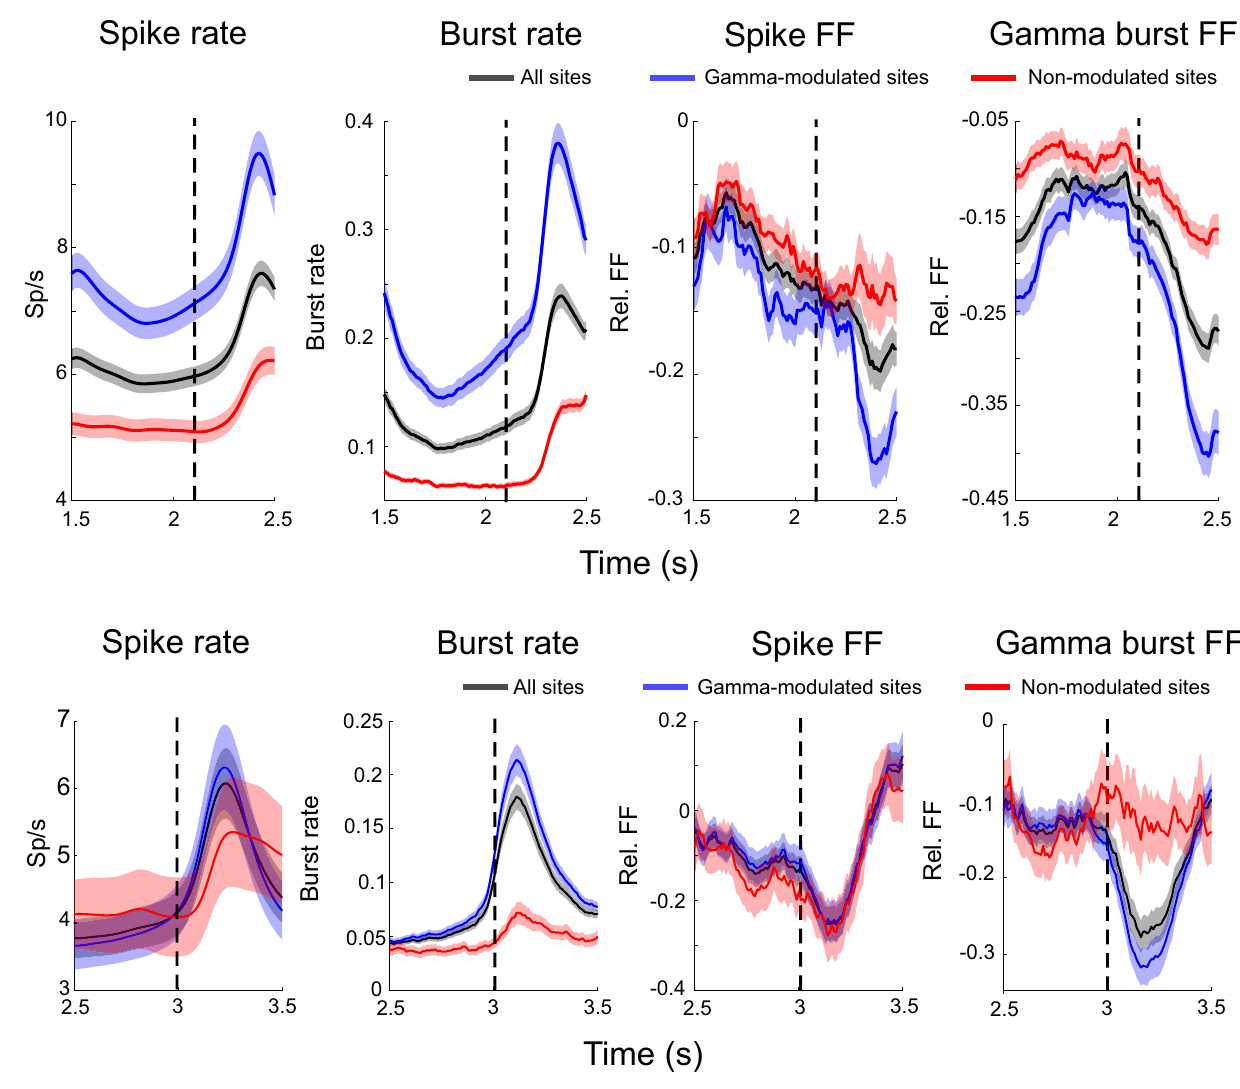
Figure 5. Burst and spike variability during test stimulus. Same as in Figs. 2 and 3, but focusing on the test periods for Task 1 (top) and Task 2 (bottom). Test stimulus onset is marked by dotted vertical lines in all